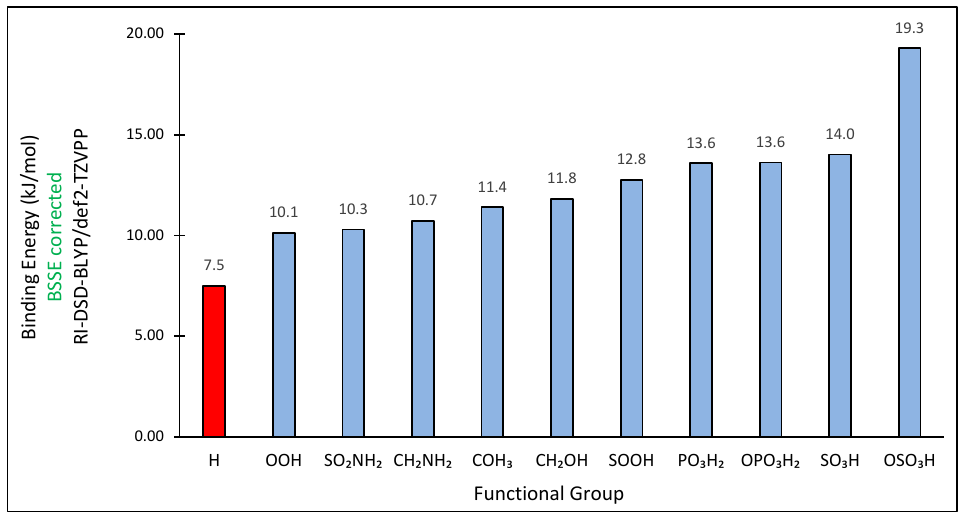
Figure 2. The 10 substituted benzenes (blue) with the highest NO binding energy and the unsubsti- tuted benzene (red) for comparison, calculated at the RI-DSD-BLYP/def2-TZVPP level of theory and corrected for BSSE.